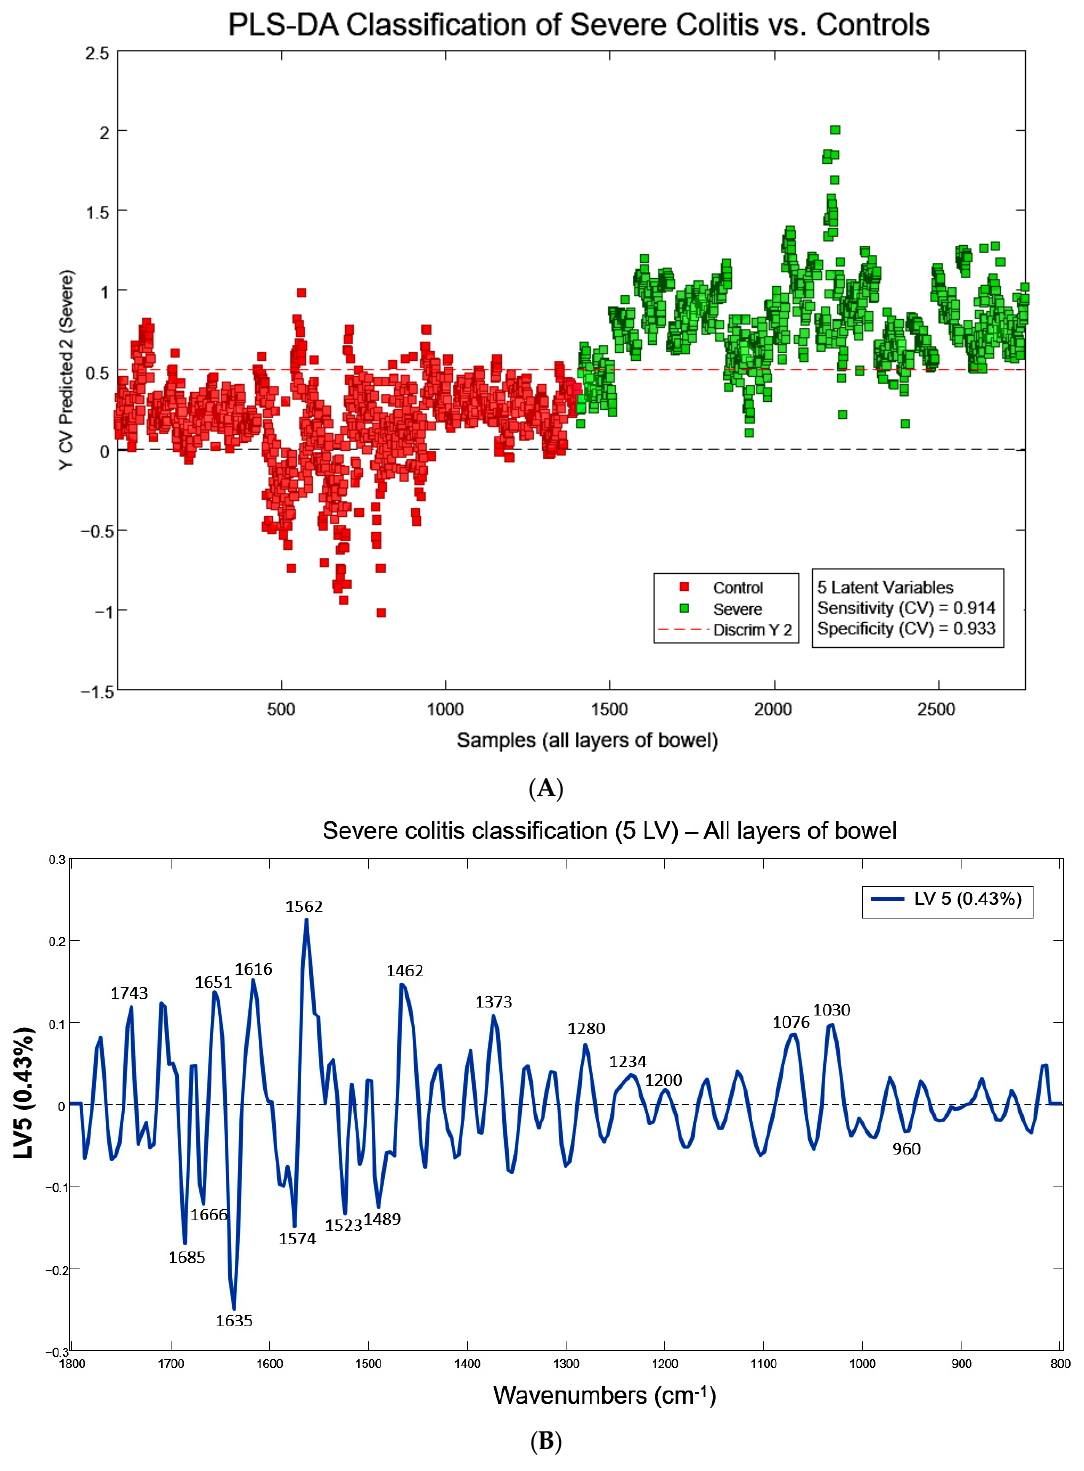
Figure 5. Partial least squares discriminant analysis model classifying spectra from all bowel wall layers as healthy tissue or severe colitis. ( A ) Classification of spectra from all layers of the bowel into controls and colitis. ( B ) All five latent variables included in the classification model for severe colitis.